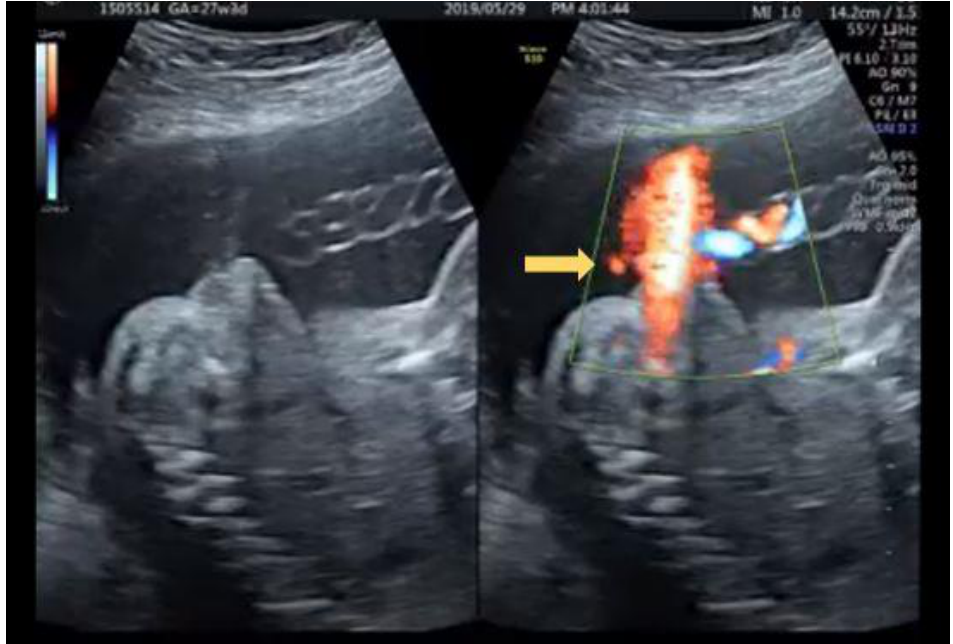
Figure 11. Fanning of urinary stream originated proximal to perineum under color Doppler (ar- row).